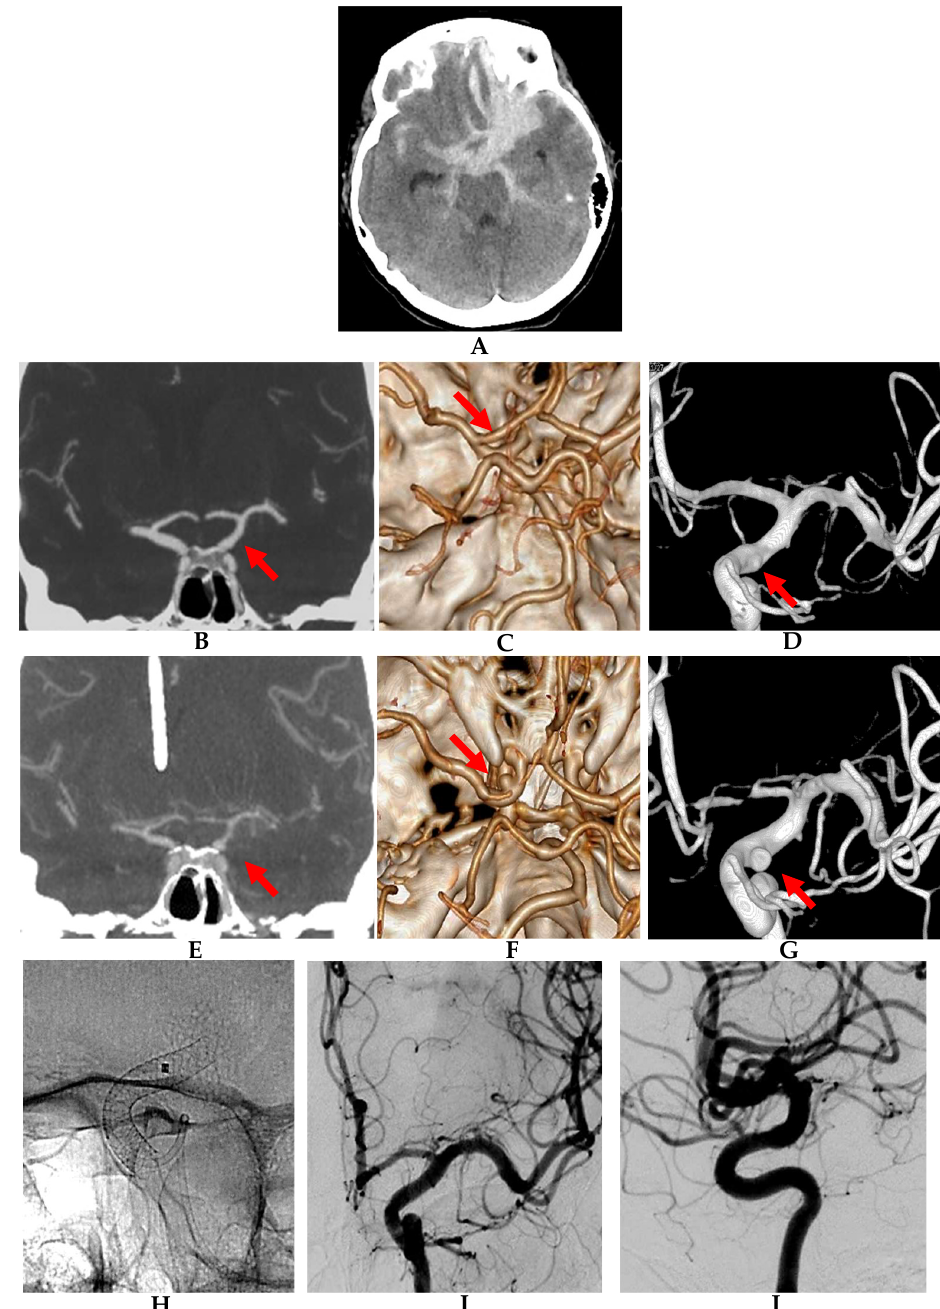
Figure 1. Growing blister aneurysm in a 55-year-old female (patient 5). ( A ) Admission non-contrast head CT showing extensive basal subarachnoid hemorrhage (SAH) lateralized to the left carotid cisterns and extending subfrontally. ( B ) Admission coronal CT angiogram (CTA), ( C ) CTA reconstruction image, and ( D ) 3D reconstruction of a digital subtraction angiogram on anteroposterior view showing signs of subtle vasculopathy at the ventrolateral wall of supraclinoid left ICA (red arrow), but not a clear aneurysm. ( E ) Coronal CTA, ( F ) CTA reconstruction image, and ( G ) 3D reconstruction of a digital subtraction angiogram on anteroposterior view obtained on day 8 after subarachnoid hemorrhage (SAH) showing development of angiographic vasospasm and clearly depicting a left ICA supraclinoid aneurysm (red arrows). ( H ) Magnified radioscopic image of the implanted flow diverter stent. ( I , J ) Digital subtraction angiograms of the left ICA obtained 4 months after the endovascular intervention, anteroposterior and lateral magnified views, showing remodeling of the stented arterial segment with no signs of residual aneurysm and only mild signs of in-stent